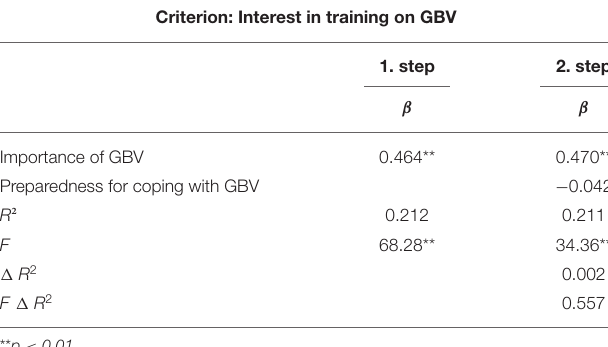
TABLE 2 | Prediction of interest for training on GBV for students.